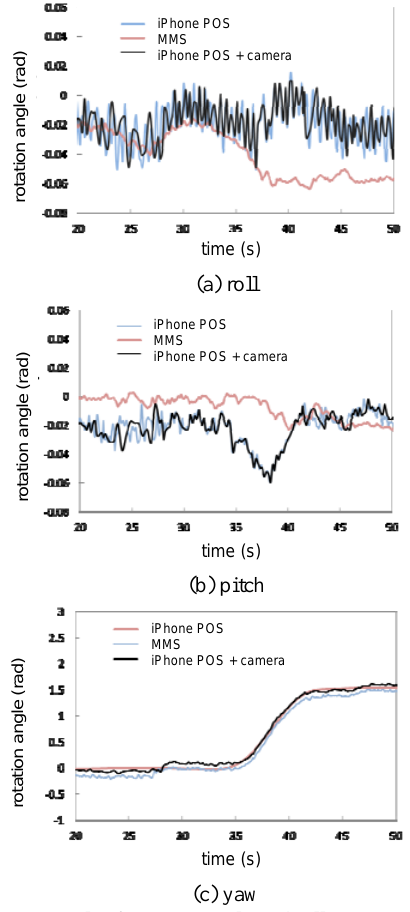
Figure 9. Result of rotation angle with all sensors